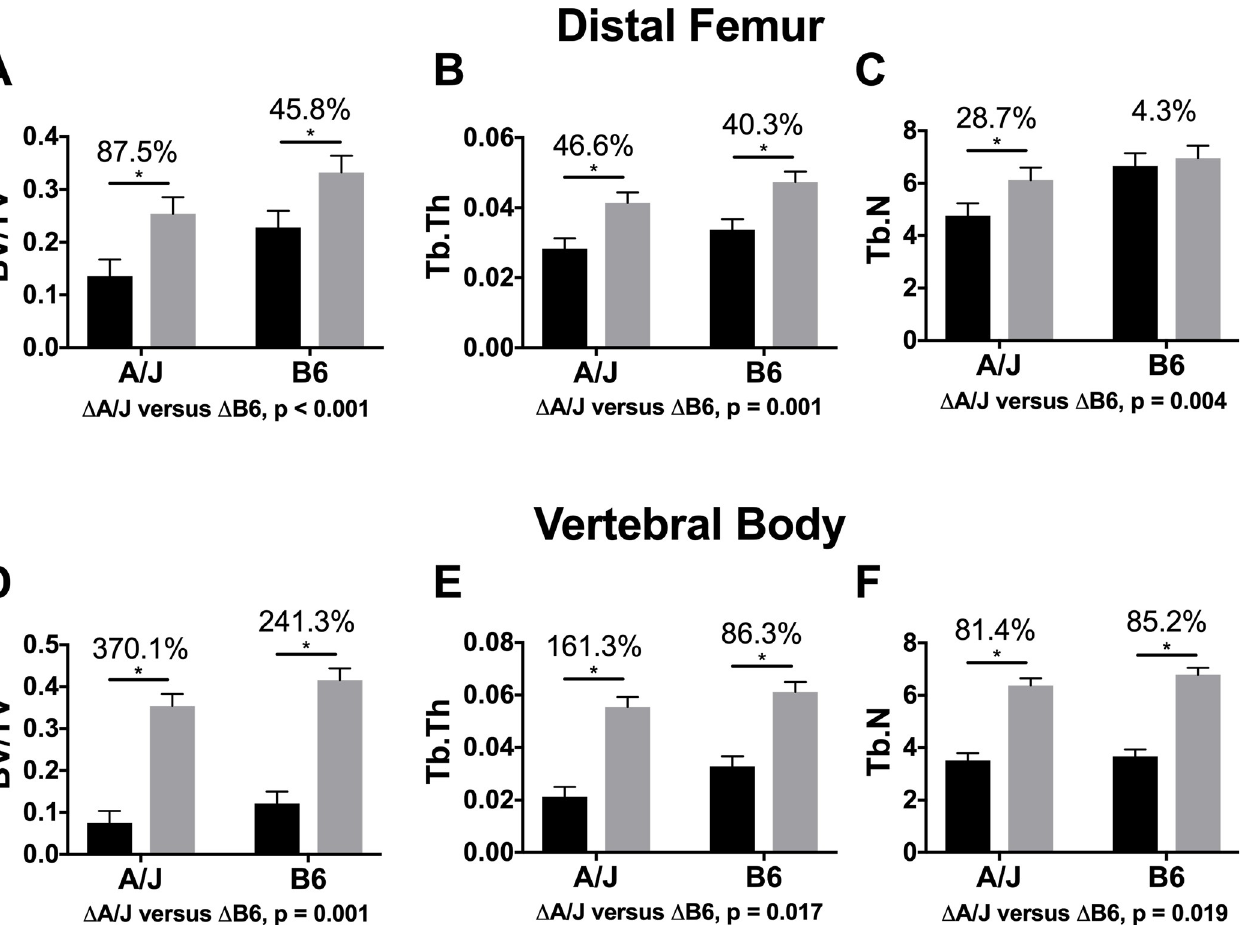
Fig 5. Analysis of nanoCT images acquired for the distal femur. Data showed a greater bone volume fraction (A) in treated A/J and B6 femurs compared to controls. This was a result of a significantly greater trabecular number for treated A/J but not for B6 (B), and a significantly greater trabecular thickness for both treated A/J and B6 femurs (C). Analysis of nanoCT images acquired for the vertebral body revealed significantly greater trabecular bone volume fraction (D) for both A/J and B6, resulting from both greater Tb.Th (E) and Tb.N (F) with treatment. Main effects by strain and treatment as well as the interaction of strain by treatment were tested using an ANOVA. Percent changes were calculated from least square mean differences of Tukey pairwise comparisons (p < 0.05). Black bars = Vehicle and gray bars = Scl-Ab treated.